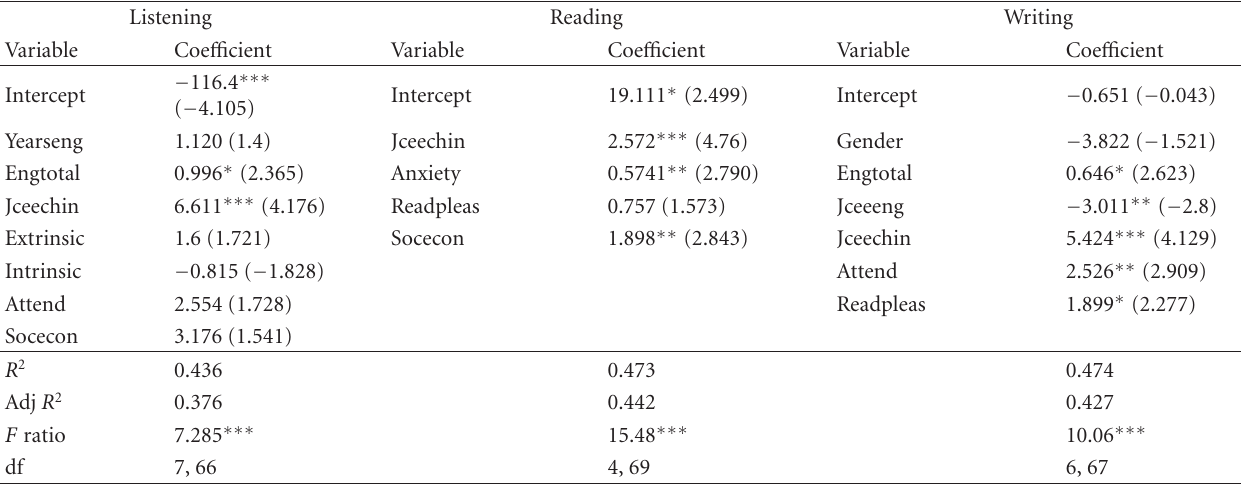
Table 5: Regressions for dependent variables: listening, reading, and